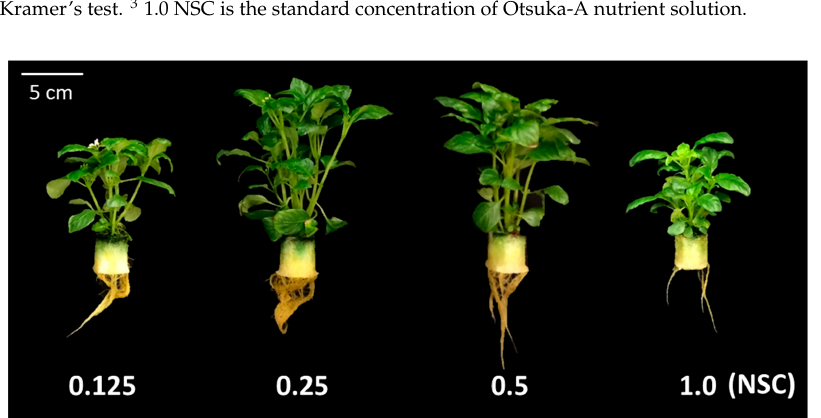
Figure 3. Effects of nutrient solution concentration (NSC) on projected leaf area ( A ) and total leaf area ( B ) of O. pumila in experiment 1. The projected leaf area was measured every week after 21 days after the start of the treatment (DAT), and the total leaf area was measured at 63 DAT. The treatments were 0.125, 0.25, 0.5, and 1.0 NSC. Vertical bars indicate S.E. ( n = 8). Different letters indicate significant differences among the treatments at p < 0.05 by Tukey–Kramer’s test. The chlorophyll concentration at 0.125 NSC was significantly lower than that at the other NSCs, approximately half of that observed with the other three treatments (Figure 4). The chlorophyll concentration was saturated at approximately 65–70 μ g cm − 2 at treatments above 0.25 NSC.